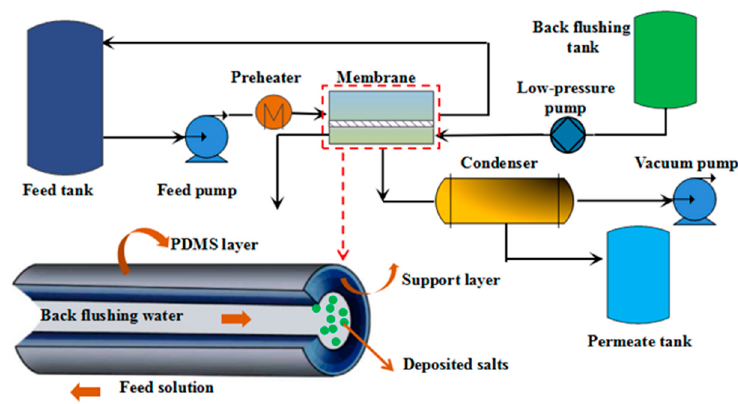
Figure 2. Schematic drawing of the pervaporation and backflushing units.